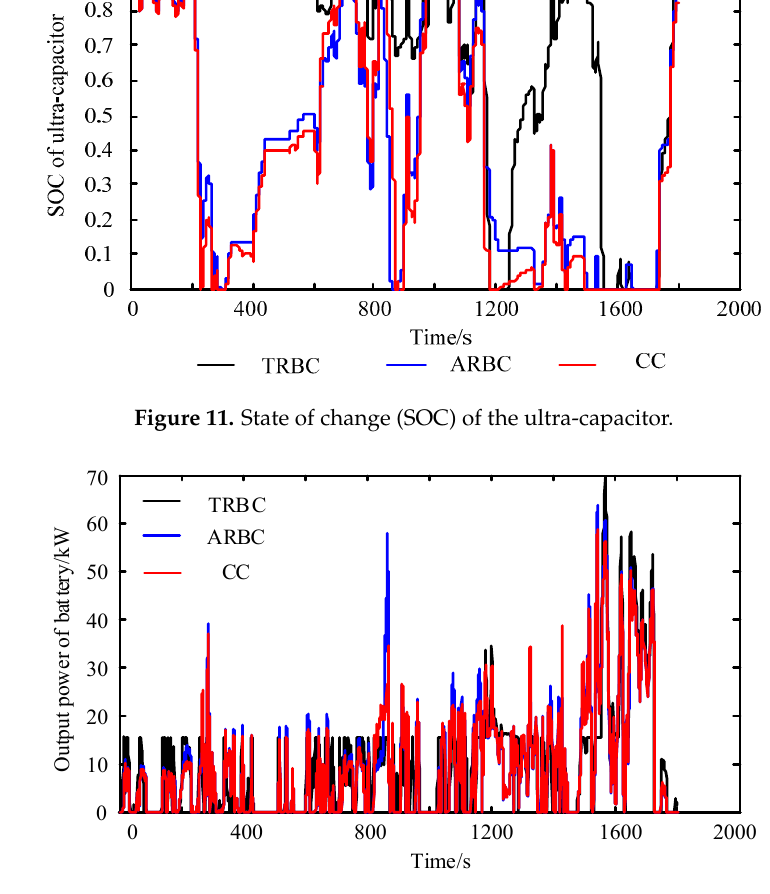
Figure 12. Output power of battery.